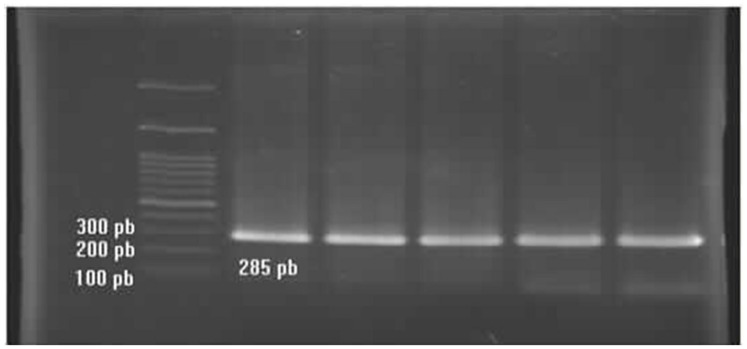
PCR products of the Ovar-DRB1 gene.